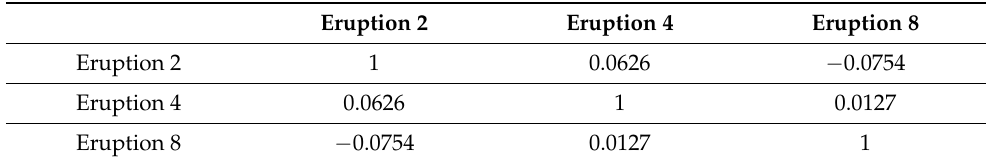
Table 1. Correlation matrix for volcanic eruptions.